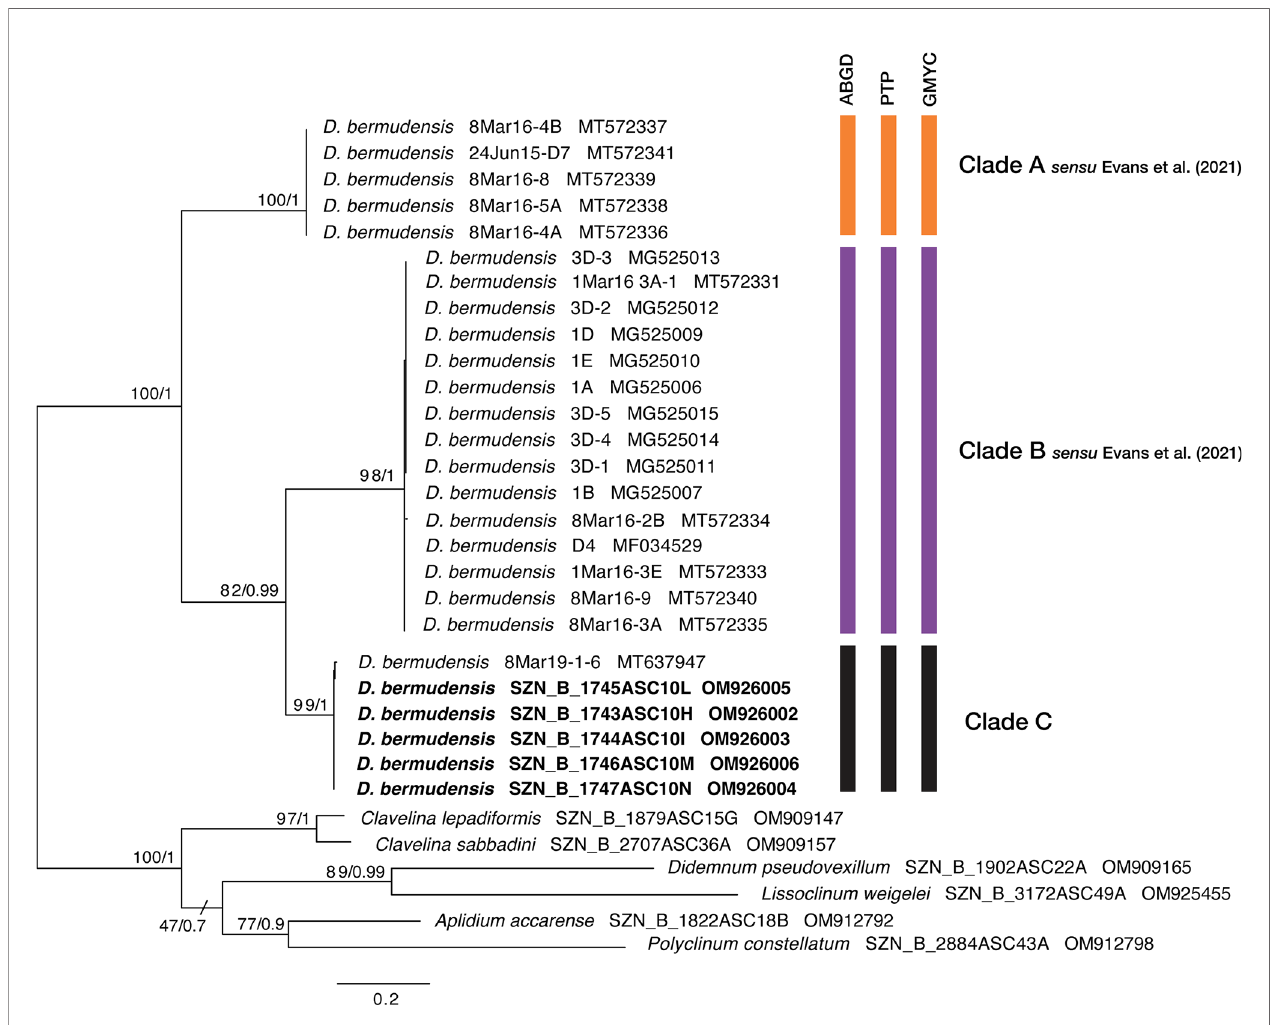
FIGURE 4 | Best ML phylogenetic tree obtained from selected COI sequences. Numbers above/below branches represent bootstrap (bs) and bayesian posterior probability (pp) values. Species delimitation outputs are graphically represented through bars: ABGD (Automatic Barcode Gap Discovery), PTP (Poisson Tree Process), and GMYC (Generalized Mixed Yule Coalescent). Colors of clades A and B as in Evans et al. (2021).